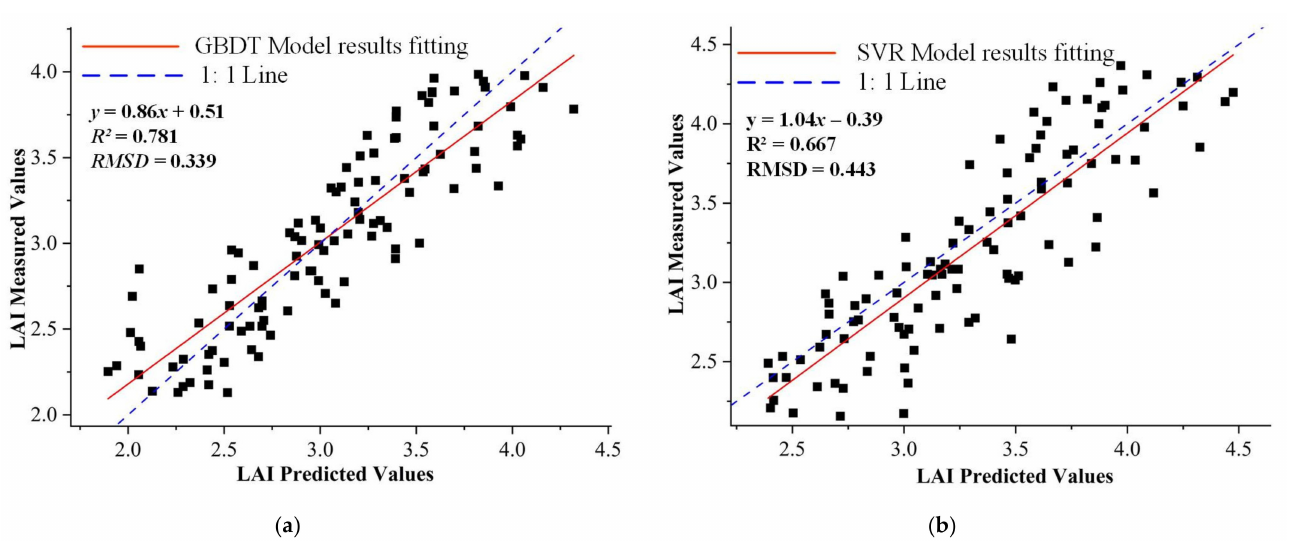
Figure 6. Regression lines between the measured and predicted LAI values for the fruit expansion stage: ( a ) results of the GBDT model; ( b ) results of the SVR model.